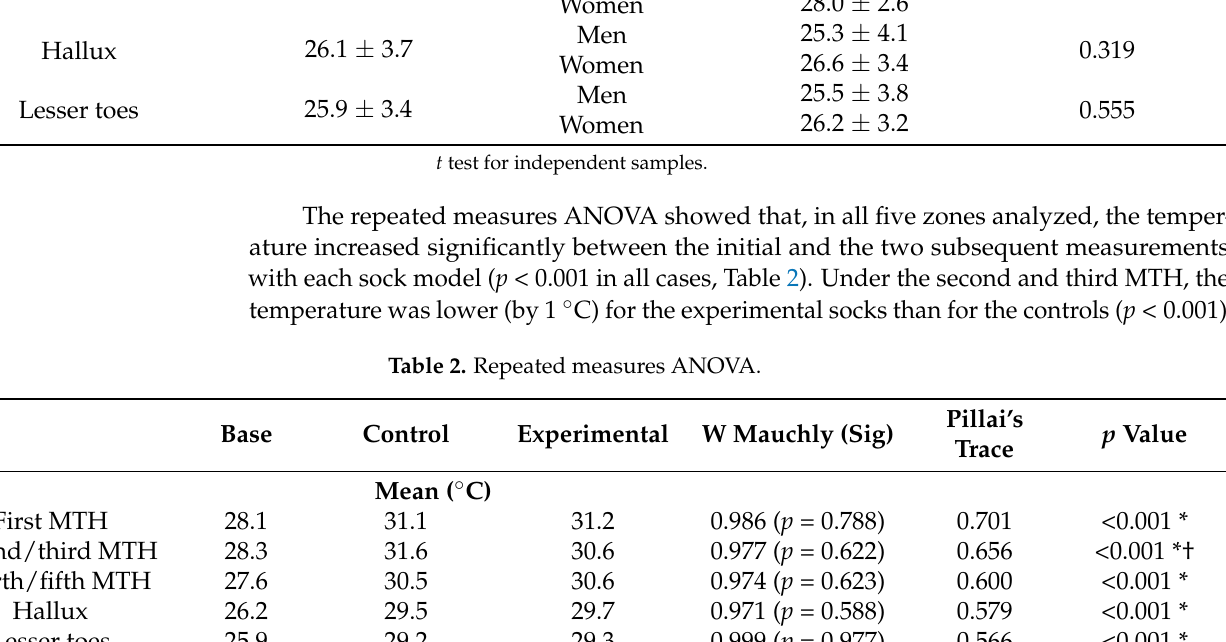
Table 1. Initial temperatures in all zones, and differences by sex.